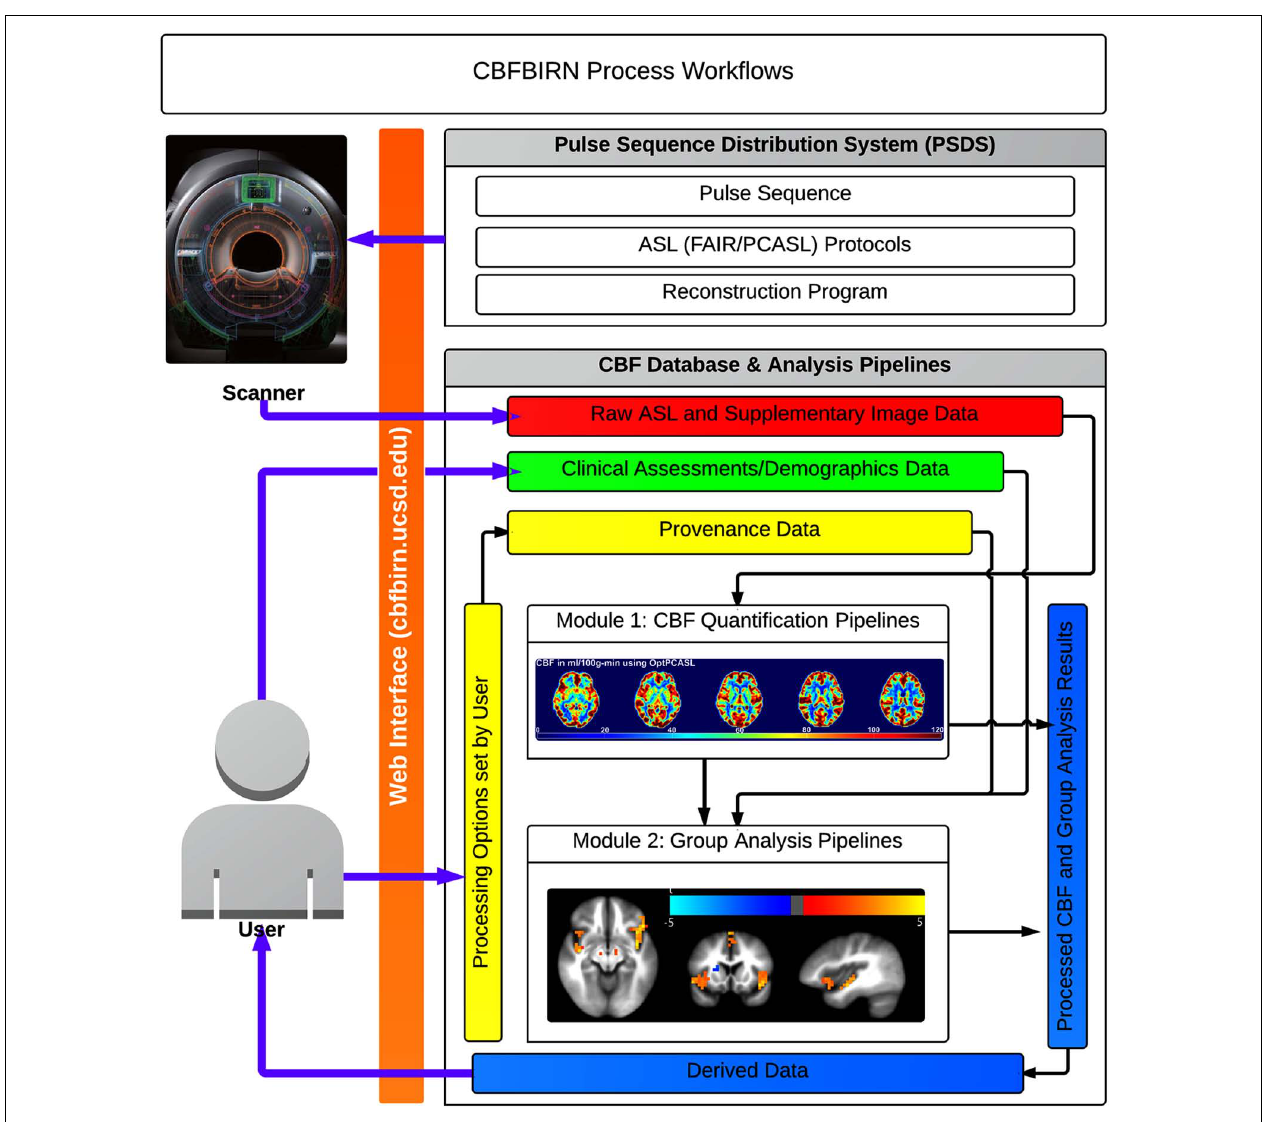
FIGURE 5 | Broad overview of CBFBIRN functionality available to end users via the web interface. Users acquire raw ASL and supplementary image data (red box) from MR scanners using an ASL protocol downloaded from the PSDS. Data are directly uploaded to the database via the